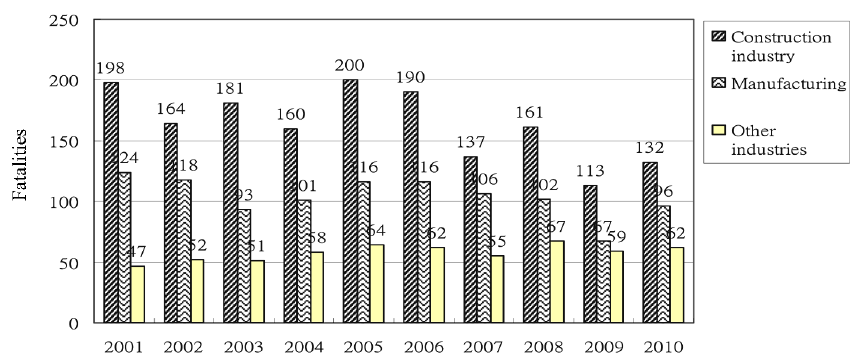
Fig. 1. Fatalities persons in construction industry and all industries (excluding deaths from occupational disease and traffic accidents), 2001–2010 Table 1. Type of bridge project under structure occupational accident Type of